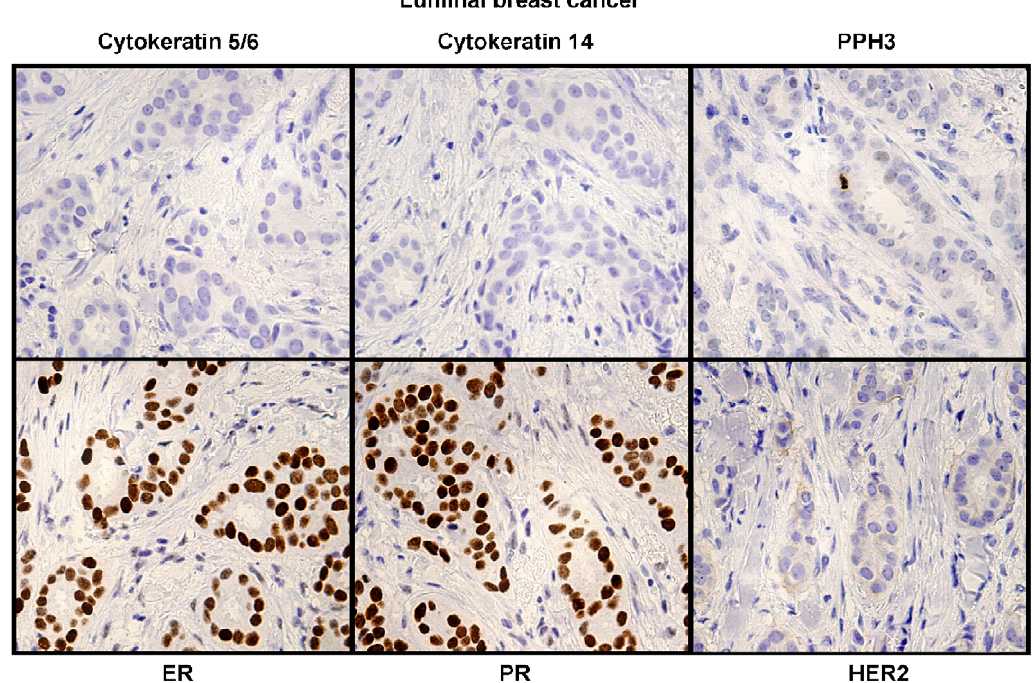
Fig. 2. Example of a luminal breast cancer stained with Cytokeratin 5/6, Cytokerratin 14, Phosphohistone H3 (PPH3), Estrogen receptor (ER), Progesterone receptor (PR) and